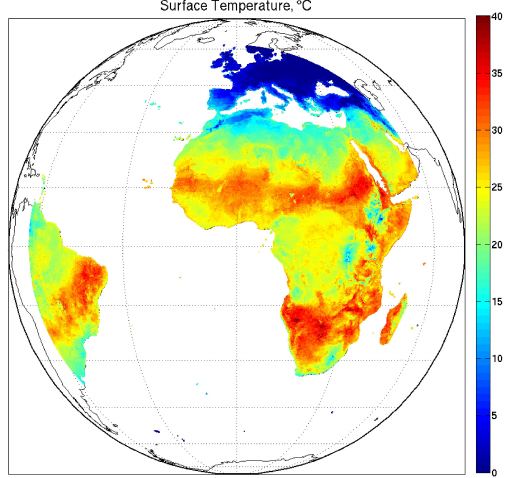
Figure 19. November 2007 map of channel emissivity at 8.7µm over the SEVIRI full